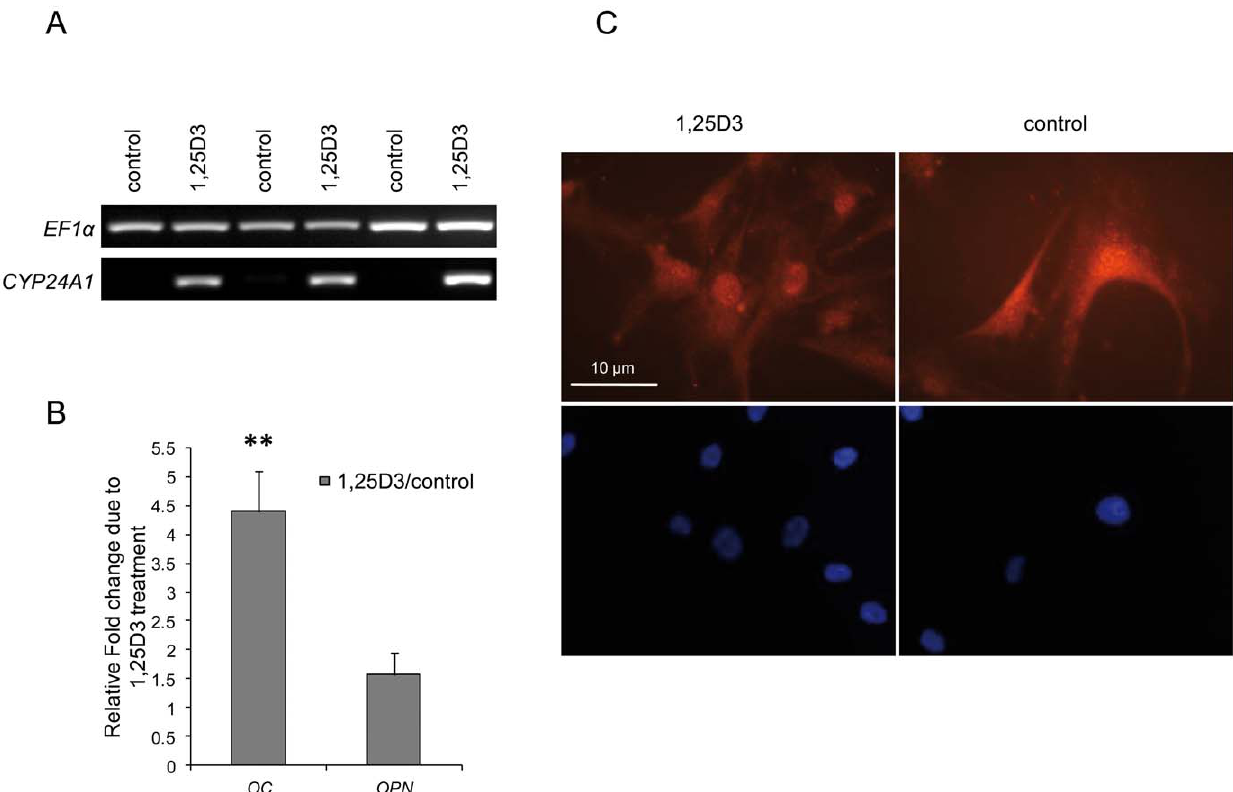
Figure 1. 1,25D3 response in hMSC. A/B 1,25D3 stimulation of hMSC resulted in a strong increase of CYP24A1 expression in all three donors. Control cells showed no CYP24A1 expression, therefore densitometric quantification was not possible (A). The induction of OC expression